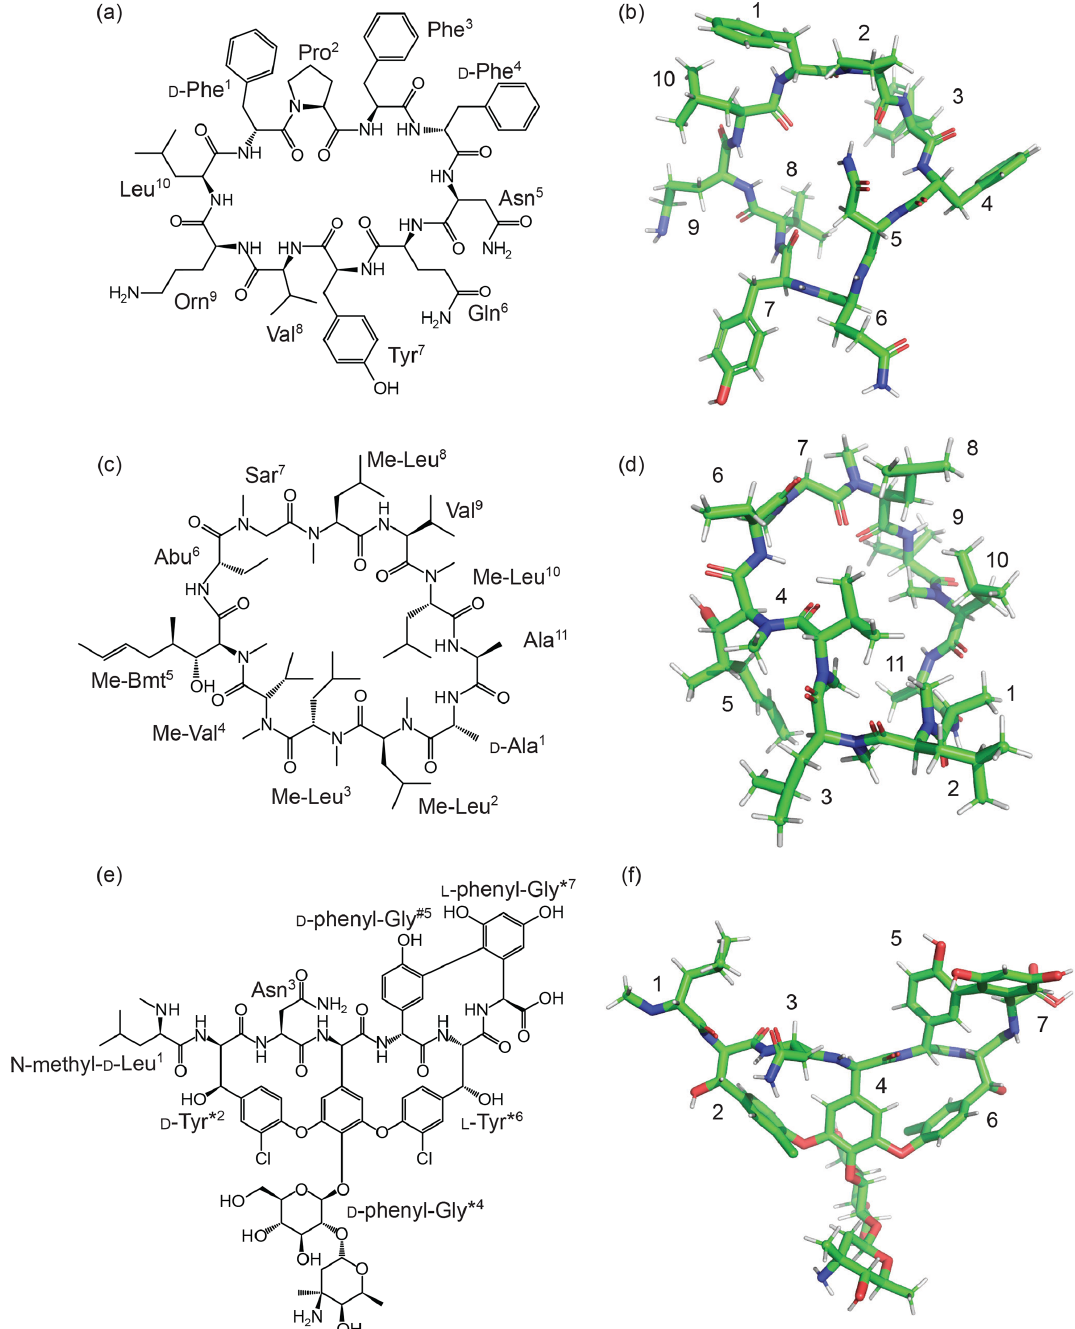
Figure 5. Structures of natural products generated from un-restrained CYANA calculations using ncAA templates generated by the ATB as described herein. (a) 2D and (b) 3D structures of tyrocidine containing a single ncAA (ornithine). (c) 2D and (d) 3D structures of cyclosporine. The sequence of cyclosporine contains five ncAAs: N-methyl-leucine (Me-Leu), N-methyl-valine (Me-Val), (4R)-4-[(E)-2- butenyl]-4,N-dimethyl- L -threonine (Me-Bmt), α -aminobutyric acid (Abu), and sarcosine (Sar). (e) 2D and (f) 3D structures of vancomycin. The amino acids of vancomycin have been abbreviated in some cases. D -Tyr* 2 is 3-chloro- β -hydroxy- D -Tyr; D -phenyl-Gly* 4 is (2-[ α - 4- L -epi-vancosaminyl]- β -1- D -glucosyl)- D -phenyl-Gly; D -phenyl-Gly #5 is 4-hydroxy- D -phenyl-Gly; L -Tyr* 6 is 3-chloro- β -hydroxy- L -Tyr; and L -phenyl-Gly* 7 is 3,5,-dihydroxy- L -phenyl-Gly. The 3D structures were generated by CYANA based on the templates obtained by the ATB–CYLIB–CYANA pipeline without experimental